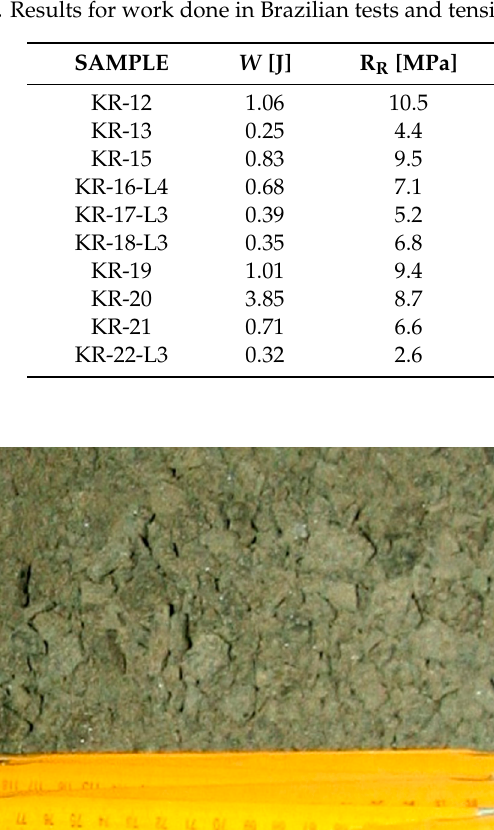
Figure 5. Outburst material from the Rudna mine [38].